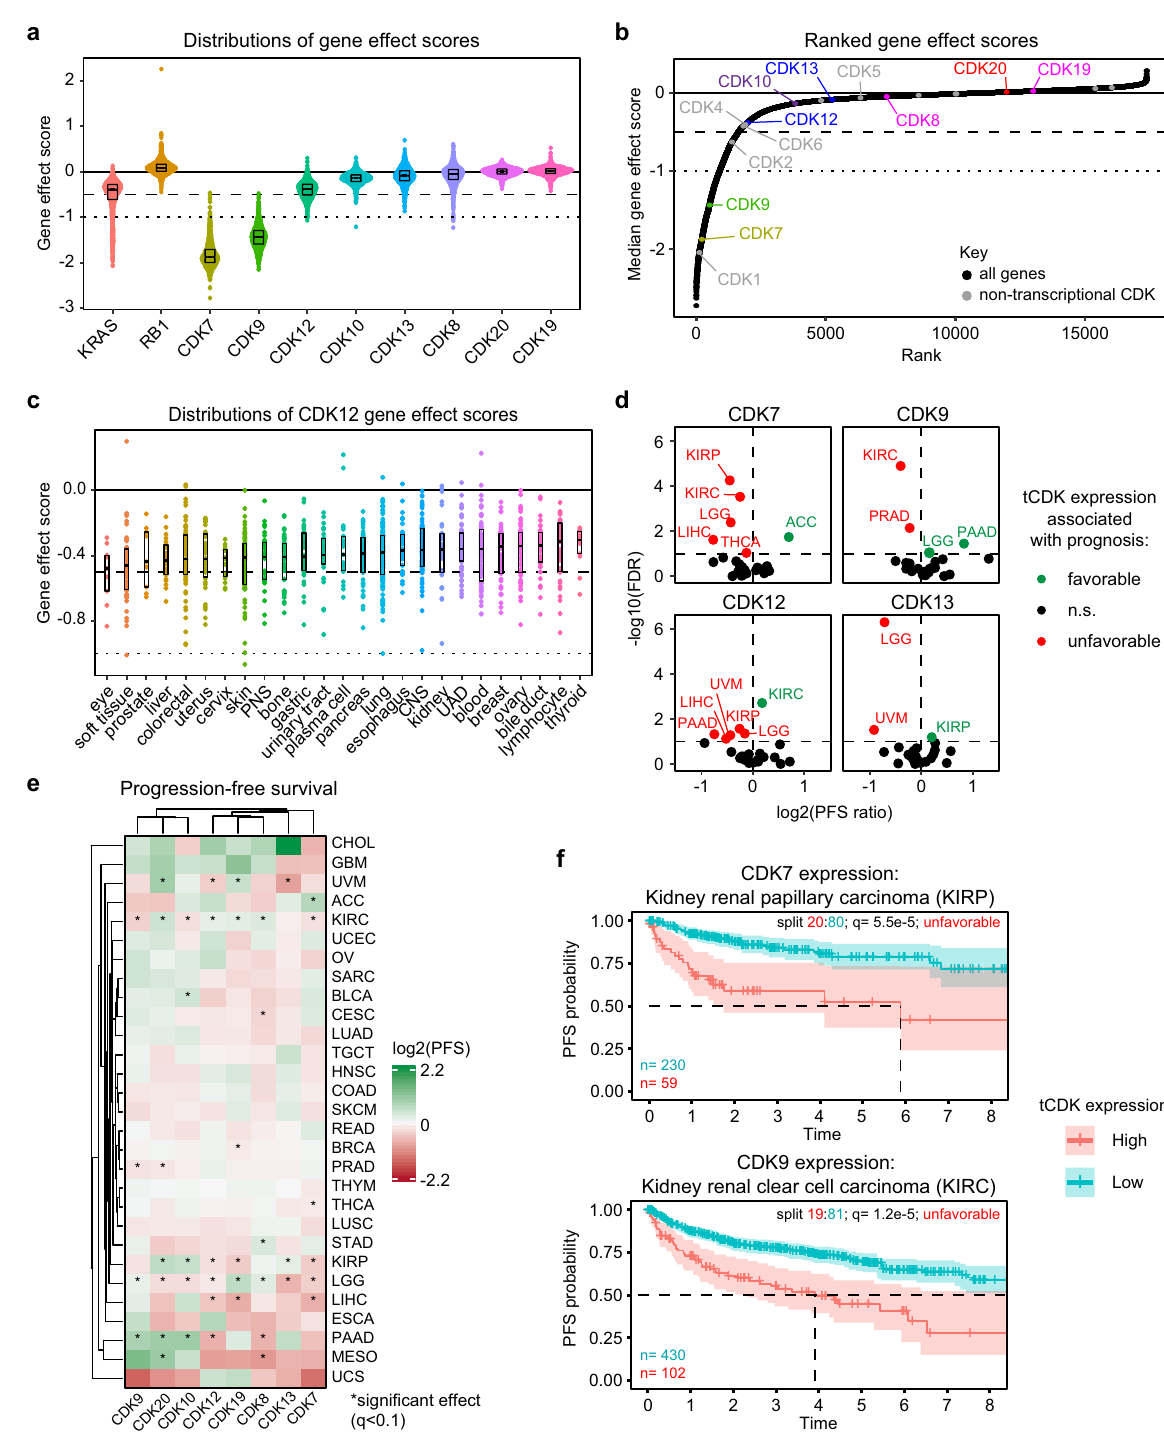
Figure 1. Human tCDKs have diverse effects on cancer cell viability. ( a ) Distributions of gene effect scores for tCDKs, proto-oncogene KRAS and tumor suppressor RB1 . Dashed line indicates threshold for essential gene effect scores (− 0.5). Dotted line indicates strong killing effect (− 1.0). Box plots show median with first and third quartiles at hinges. Whiskers extend to largest/smallest values no further than 1.5*IQR from hinge. ( b ) Ranked plot of median gene effect scores of all genes tested in DepMap data set. The location of all tCDKs (multi-colored) and non-transcriptional CDKs (gray) are denoted. (c) Distributions of gene effect scores for CDK12 across all lineages with at least 5 representative cell lines. Box plots show median with first and third quartiles at hinges. Whiskers extend to largest/smallest values no further than 1.5*IQR from hinge. ( d ) Volcano plots for prognosis associated with tCDK expression in the TCGA dataset. Results show adjusted (log2) of progression-free survival (PFS) ratio versus adjusted (− log10) false discovery rate (FDR, q value). ( e ) Heatmap showing adjusted (log2) progression-free survival (PFS) associated with tCDKs expression across TCGA cancer lineages. Dendrograms represent results from unsupervised clustering. Asterisks denote significance (FDR < 0.1). ( f ) Results from iterative Kaplan–Meier survival analysis of low (20th percentile) versus high (80th percentile) CDK7 expression in kidney renal papillary carcinoma (KIRP) and low (19th percentile) versus high (81st percentile) CDK9 expression in kidney renal clear cell carcinoma